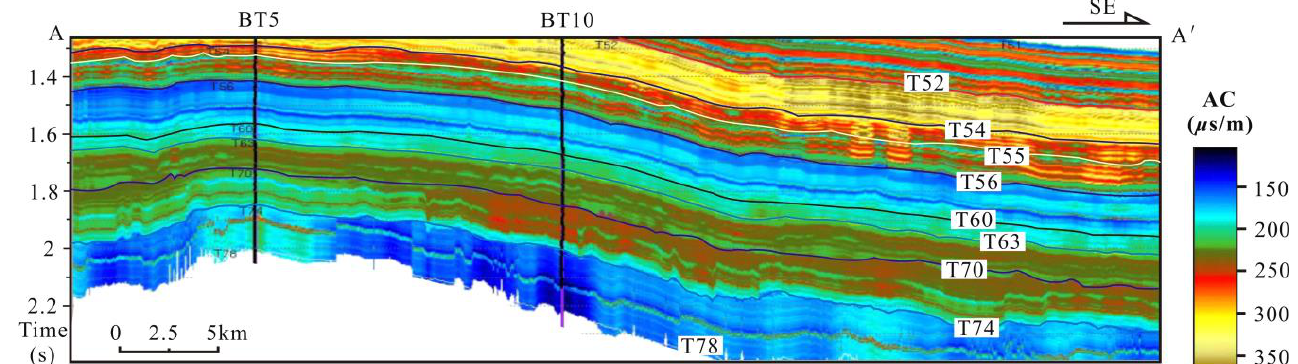
Figure 4. BT5 – BT10 well-linked 3D seismic inversion acoustic profile. See Figure 1b for section Figure 4. BT5–BT10 well-linked 3D seismic inversion acoustic profile. See Figure 1b for position. section position.